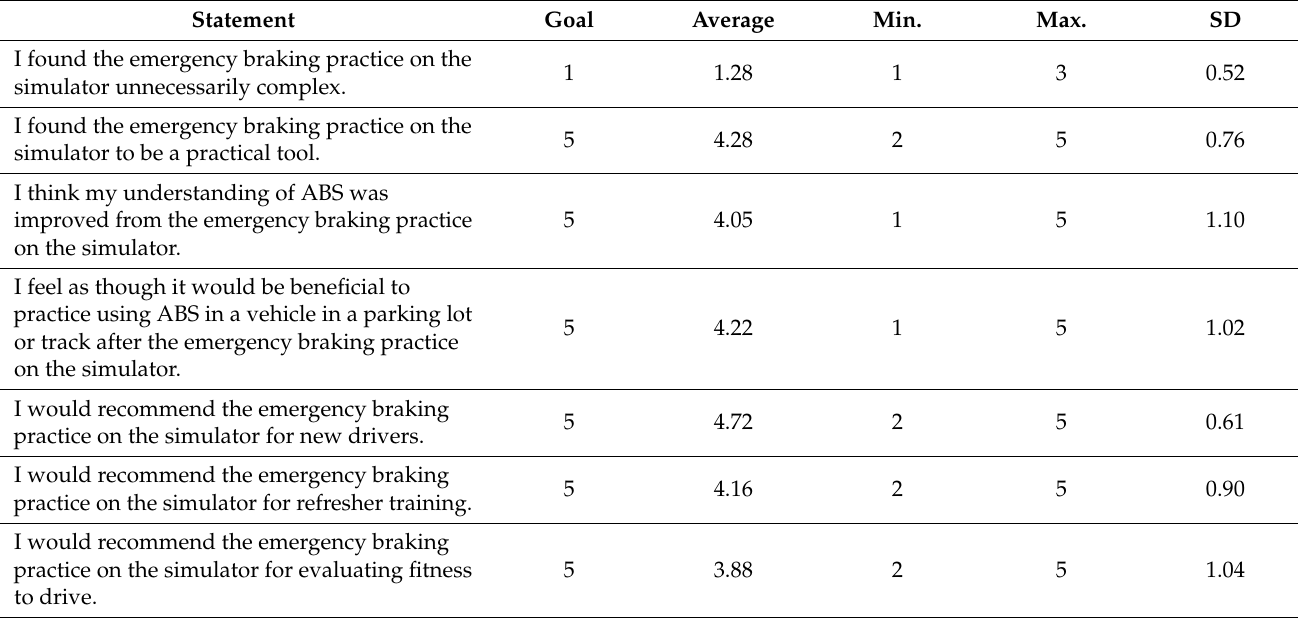
Table 4. Results for the usability